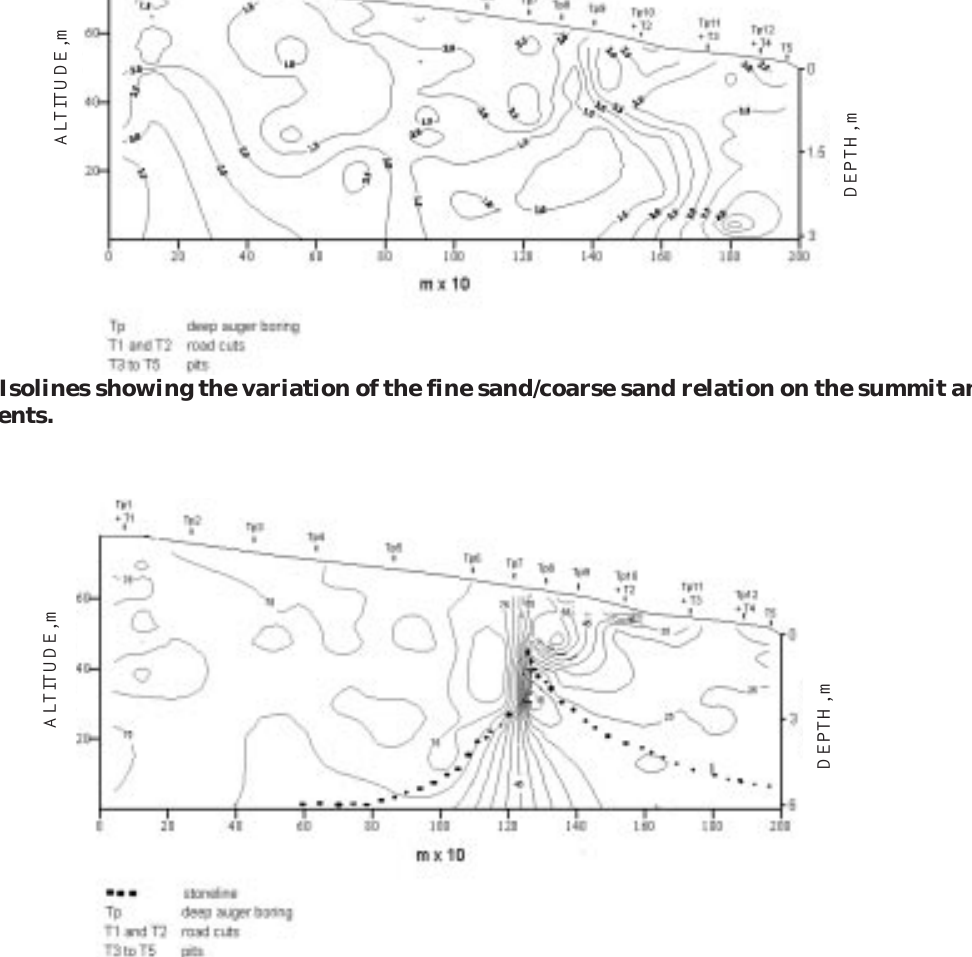
Figure 8. Isolines showing the variation of the total sand on the summit and shoulder